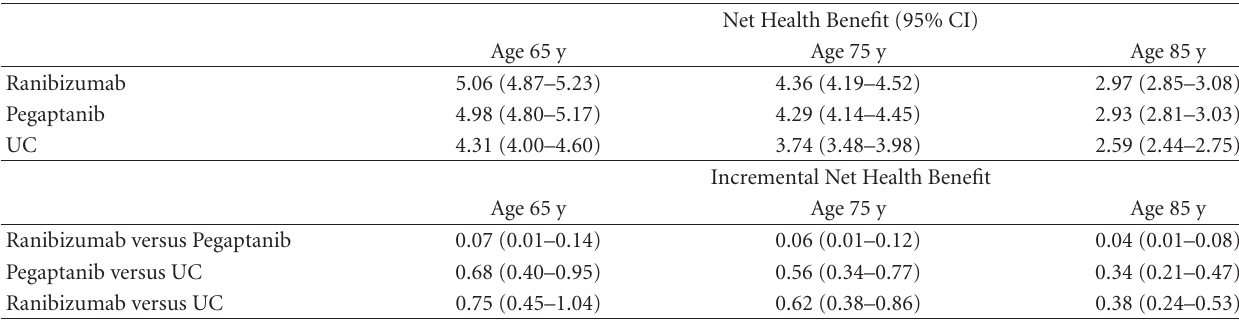
Table 3: Net health benefits (with 95% CI), and incremental net health benefits, of VEGF inhibitor treatment in NV-AMD patients, by age at treatment initiation (in quality-adjusted life years).